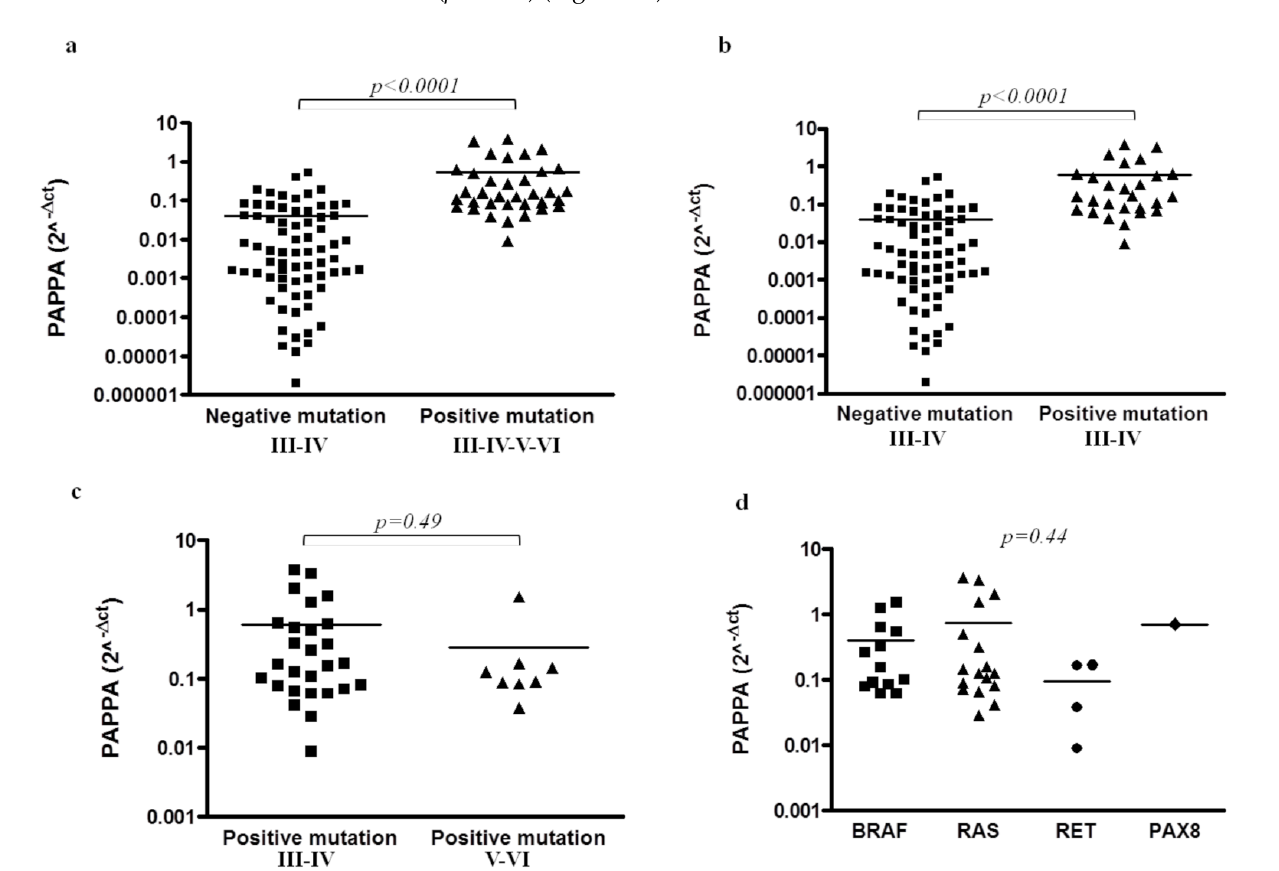
Figure 1. Pregnancy-associated plasma protein A (PAPPA) expression mRNA levels in cytological samples. ( a ) PAPPA expression in Bethesda III–IV with negative mutations (n = 72) compared to Bethesda III–IV-V–VI with positive mutations (n = 35) samples. p < 0.0001 by the